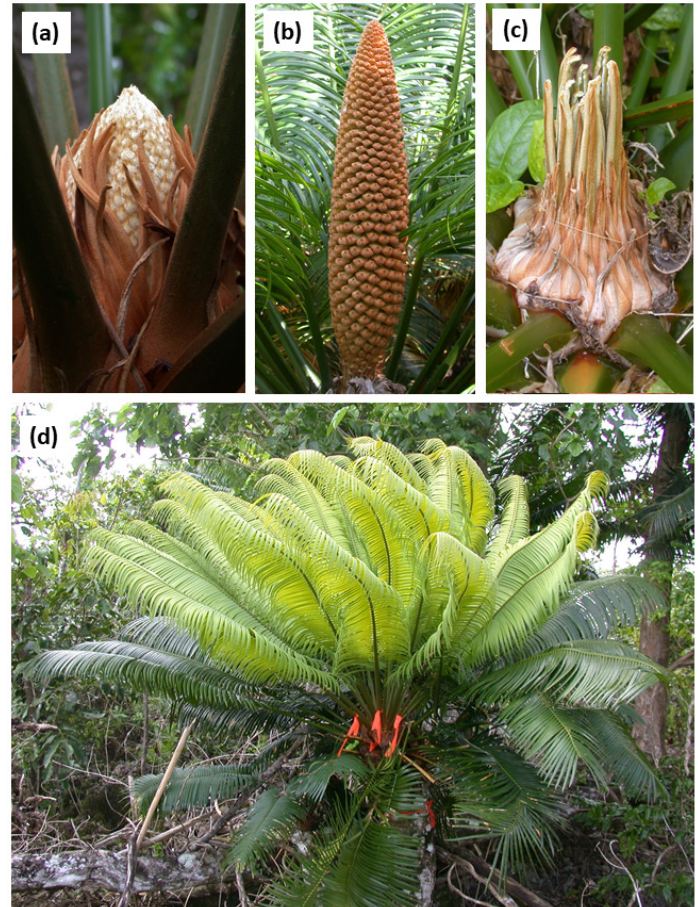
Figure 1. Male cone or synchronized leaf growth occurs from the apex of Cycas micronesica stems. (a) Male cone two days after emergence. (b) Mature male cone with eight weeks of growth. (c) Leaf growth five days after emergence, showing circinate leaflets. (d) Fully expanded leaf flush with four weeks of growth.